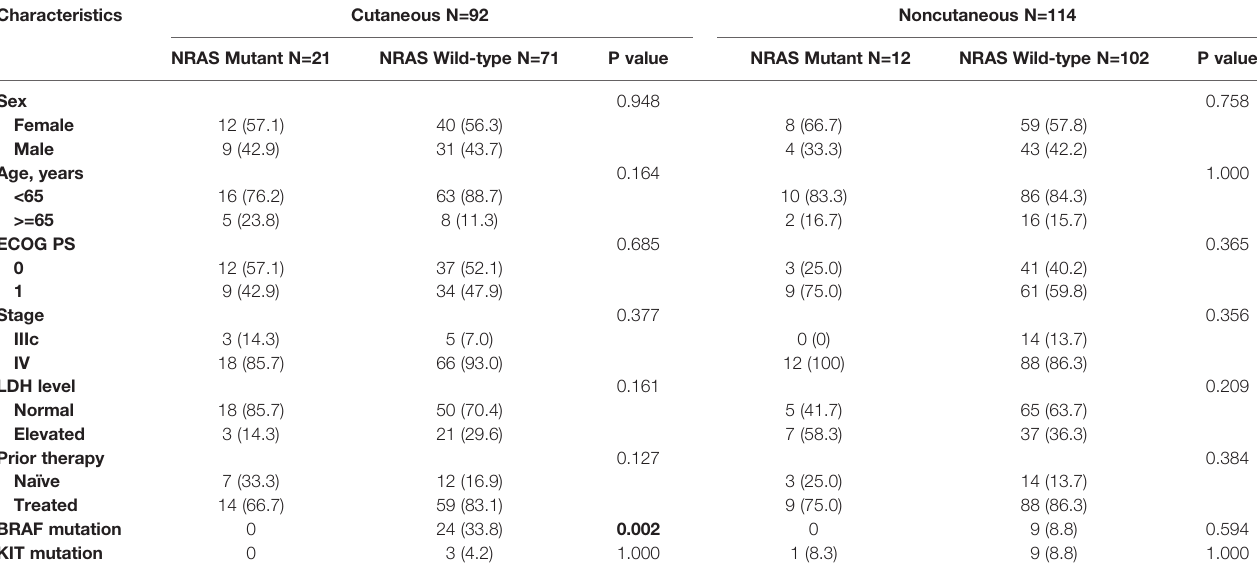
TABLE 1 | Patient characteristics. Characteristics Cutaneous